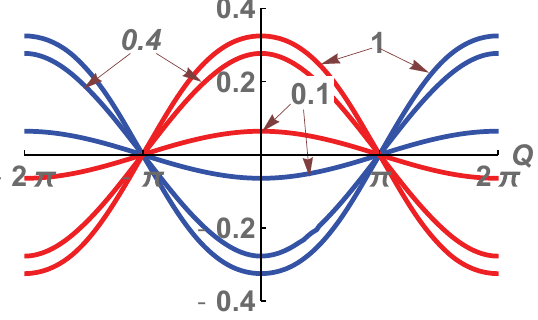
Figure 5. The gaps of edge modes with f (blue), h (red) fermion parity as functions of the flux Q calculated at τ = 0.1, 0.4, 1, µ = 1